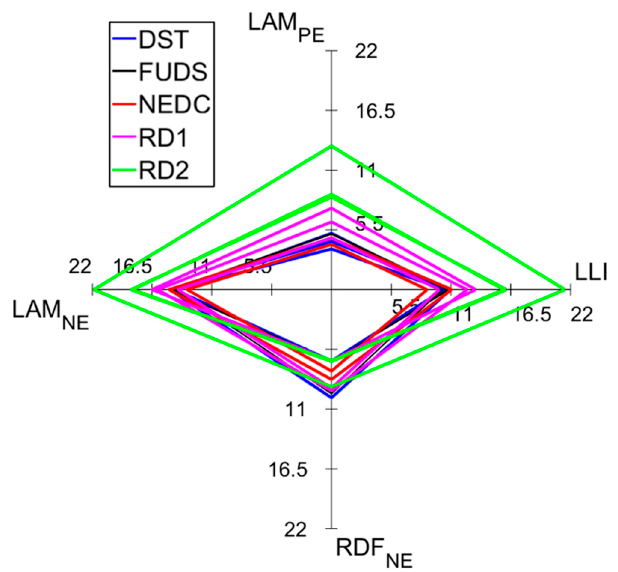
Figure 8. Spider plot of the calculated degradation modes at the onset of the accelerated stage of aging for all 15 cells.